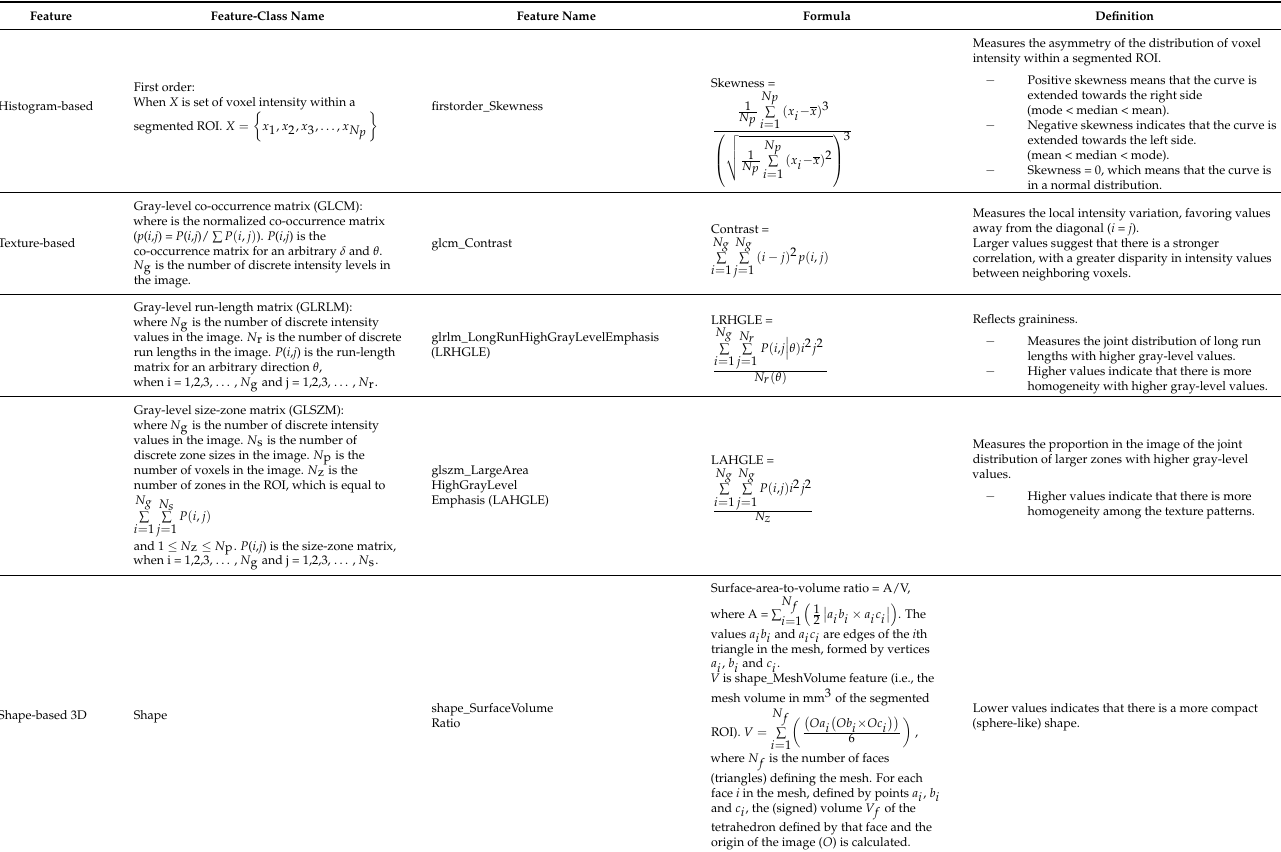
Table A1. Example of the definitions and formulas of radiomic